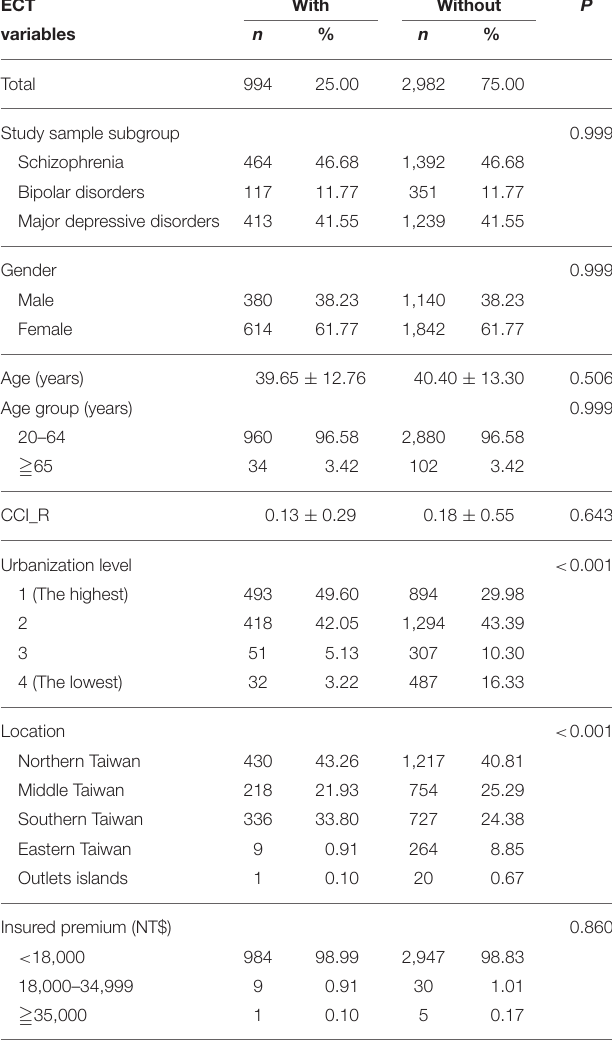
TABLE 1 | Characteristics of study at the